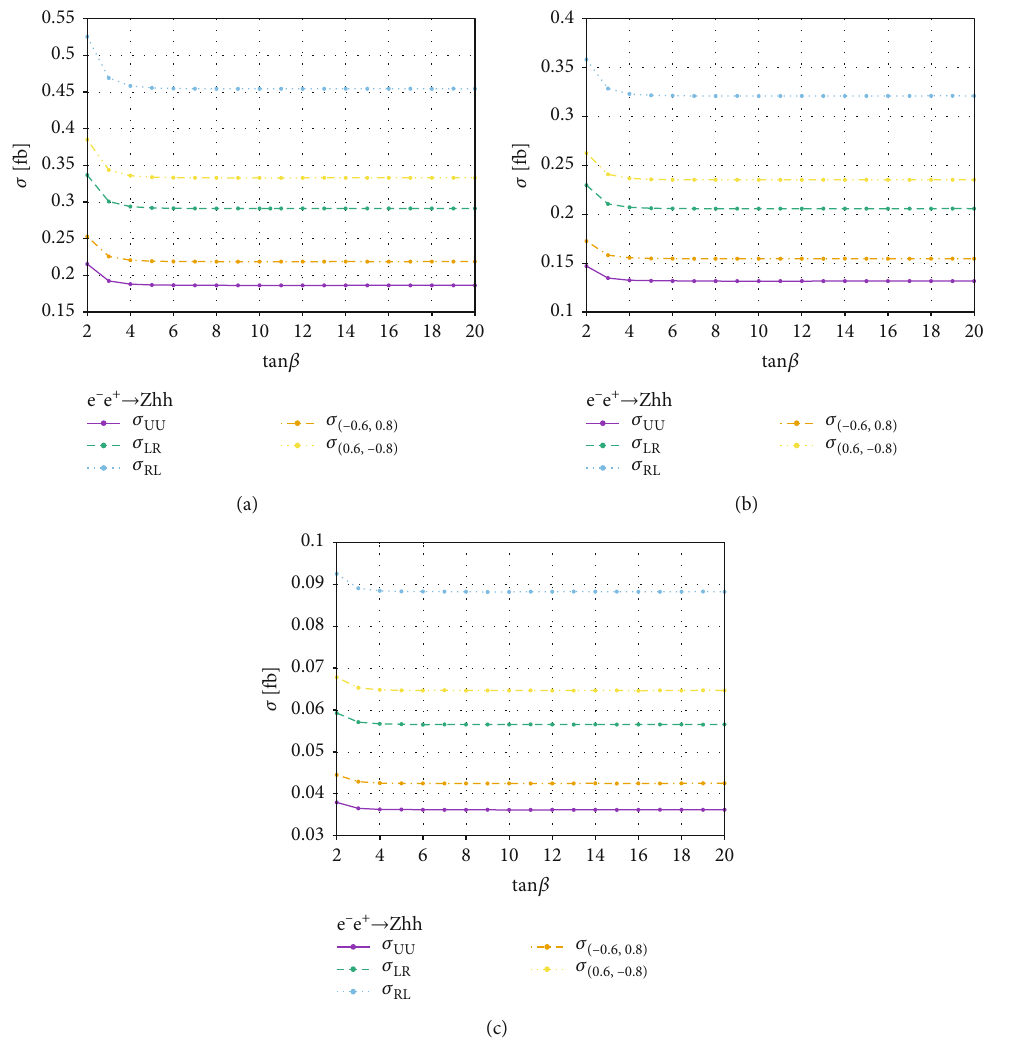
ffiffi p = 0 : 6TeV , (b) s